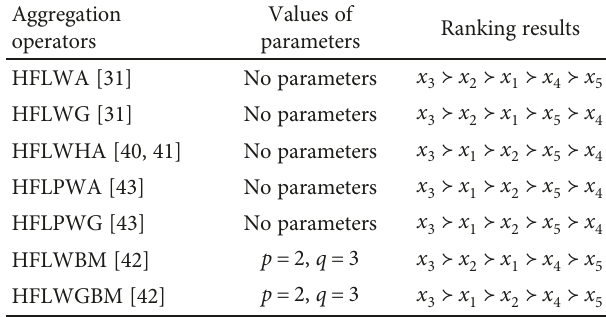
Table 3: Results by using di ff erent aggregation operators.